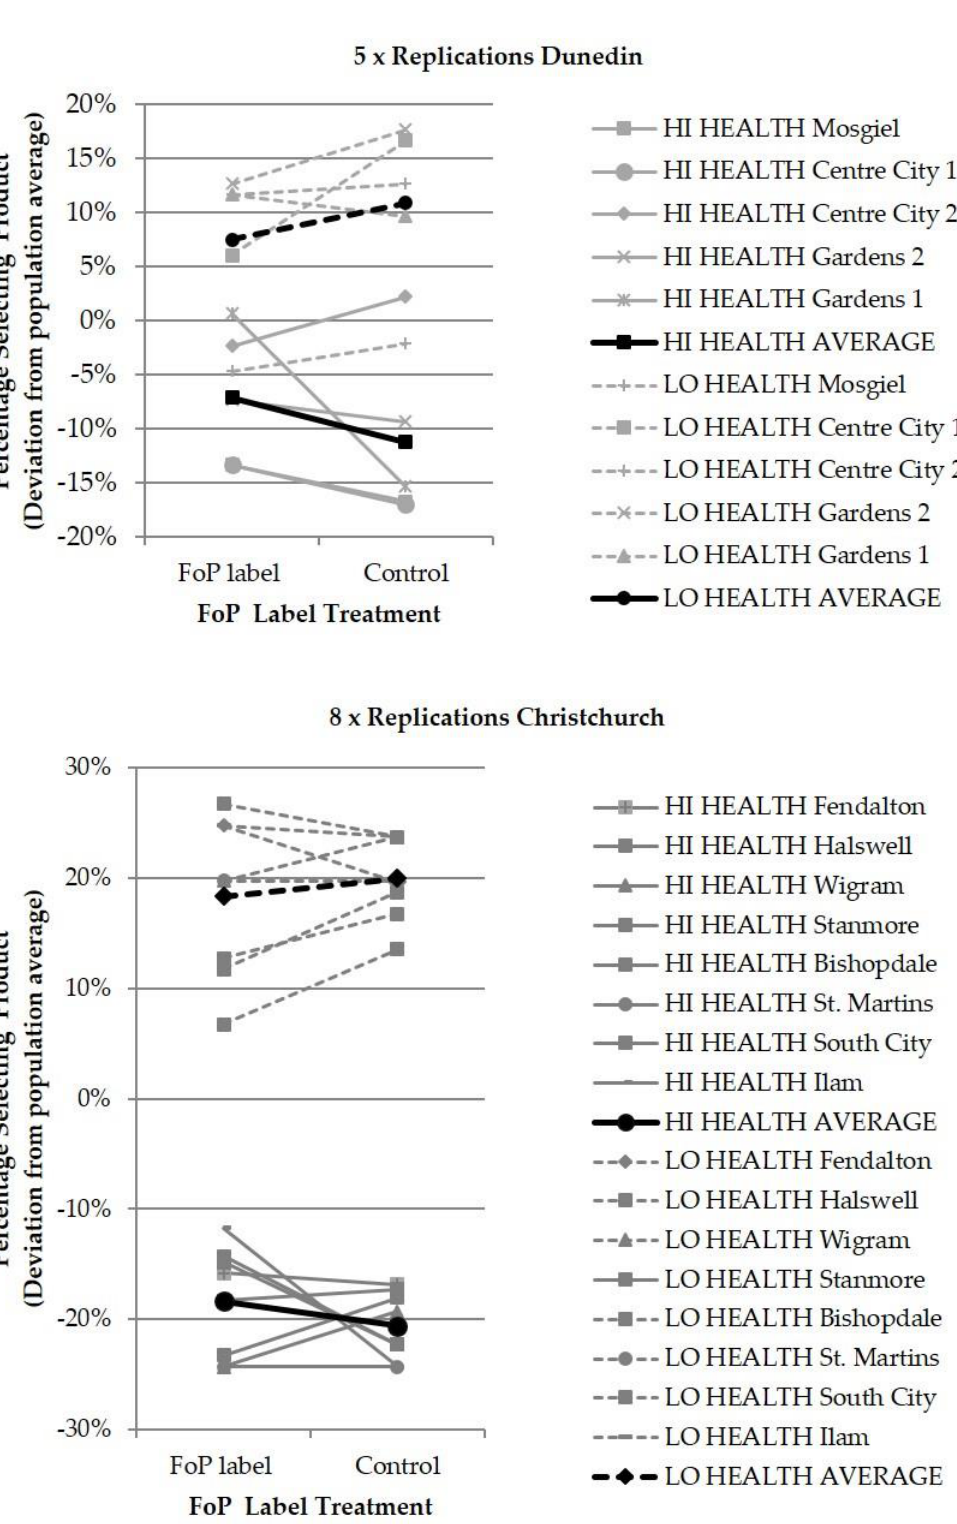
Figure 8. Results graphical presentation.